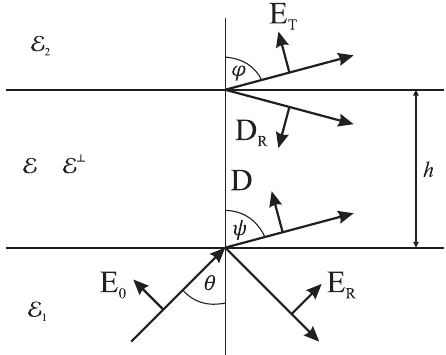
Figure 3. Anisotropic Fresnel’s model of a layer between two half-spaces. Permittivity was ε for parallel electric field and ε ⊥ for transverse field concerning the